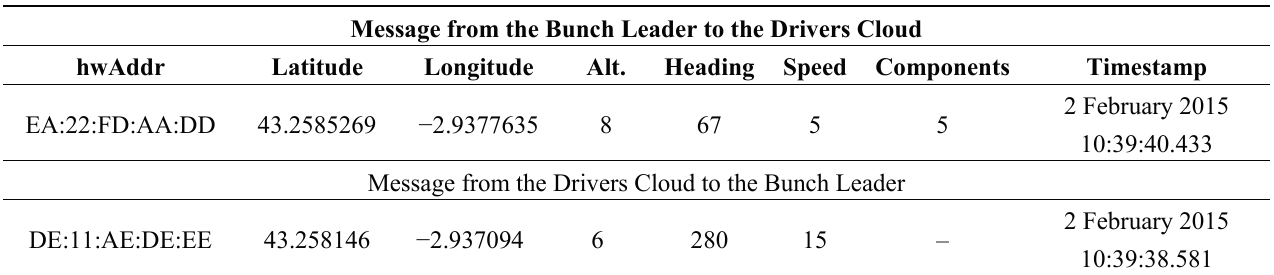
Table 3. Message format interchanged between cyclists and the Drivers Cloud.